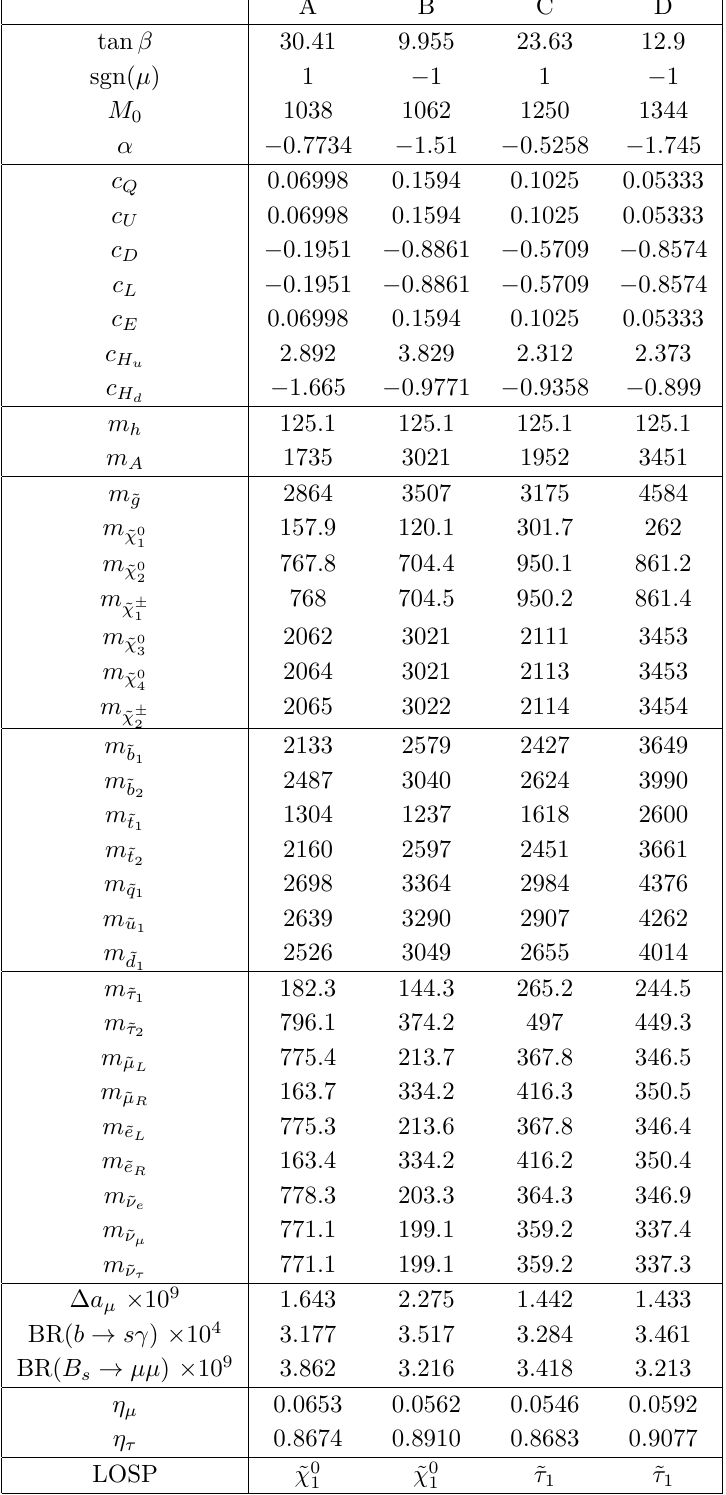
Table 1 . Benchmark sparticle mass spectra of mixed modulus-anomaly mediation for the muon g − 2